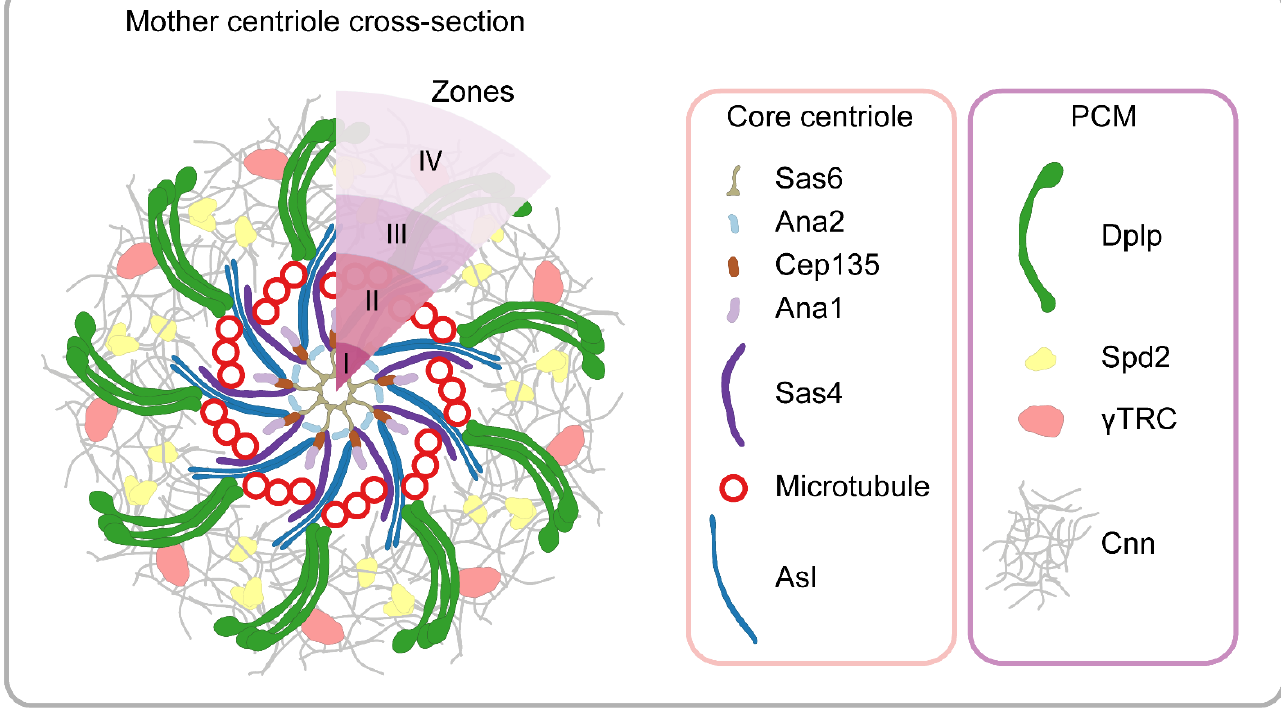
Figure 7. Schematic cross-sectional model of the mother centriole and the associated pericentriolar material at the point of mitotic entry. The molecular components of Drosophila centrosomes are organized into five zones defined by super-resolution microscopy. Note that not all centrosome-specific proteins are displayed. Additionally, note that zone V at the distal tip of the centriole is not displayed in the cross-sectional view. See text for details.